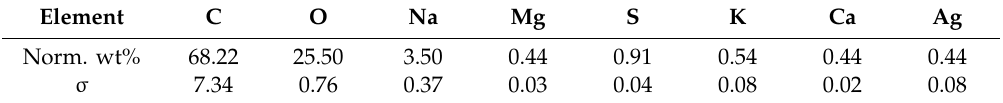
Figure 4. Field ‐ emission gun scanning electron microscope (FEG ‐ SEM) micrograph of Ma AgNPs taken at 5 kV. Table 1. Energy-dispersive X-ray spectroscopy (EDX) elemental analysis of Ma AgNPs.